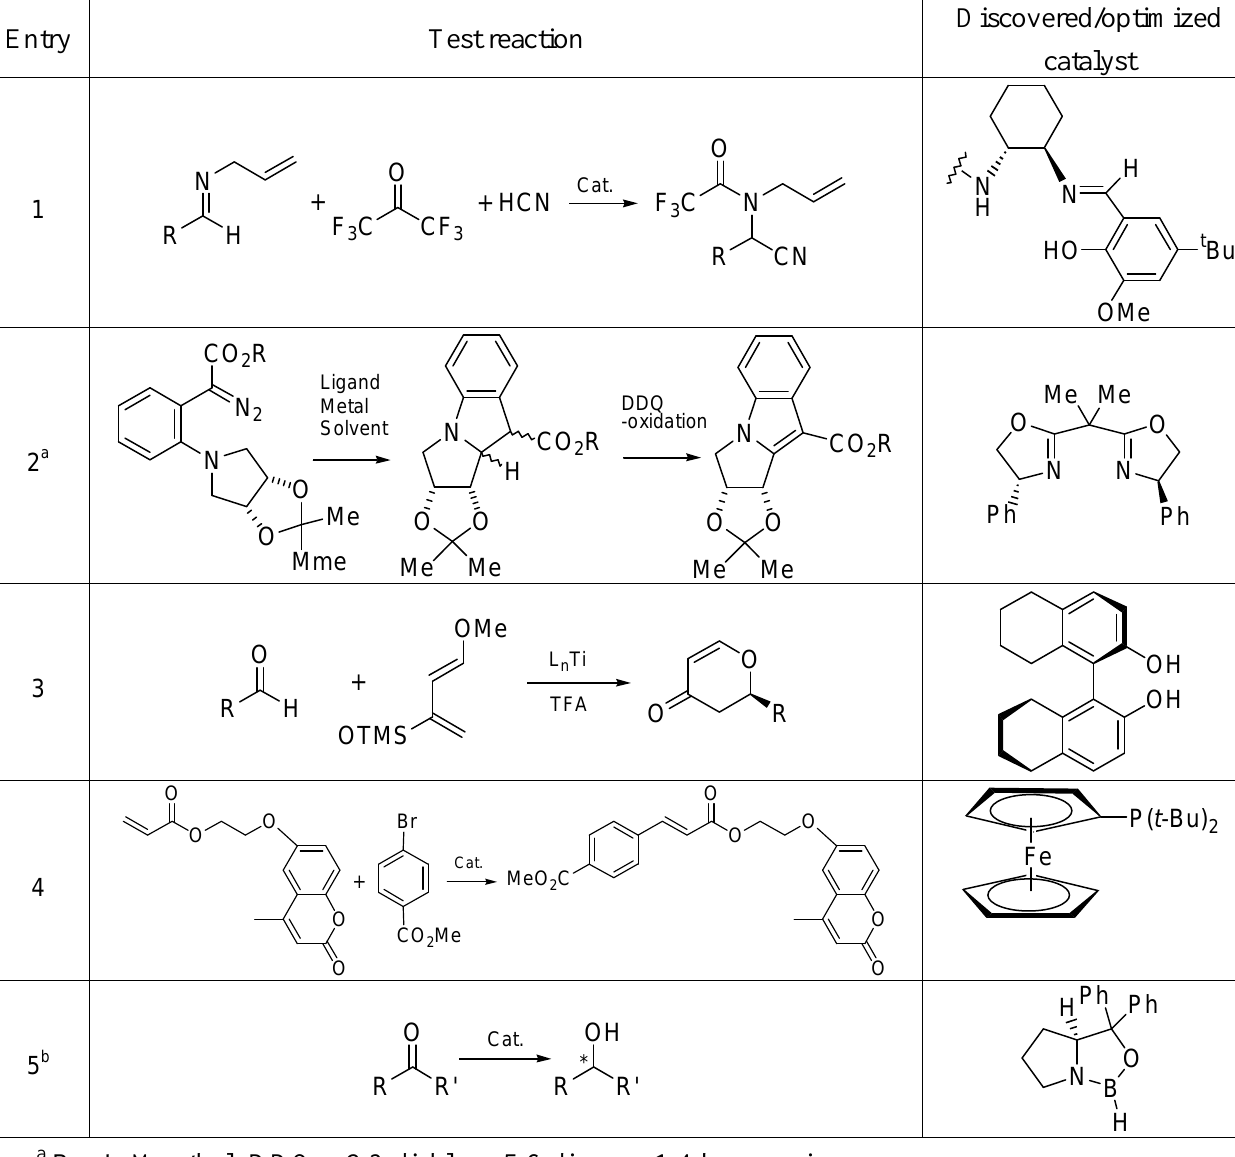
Table 1 . New catalysts discovered or optimized using high-throughput